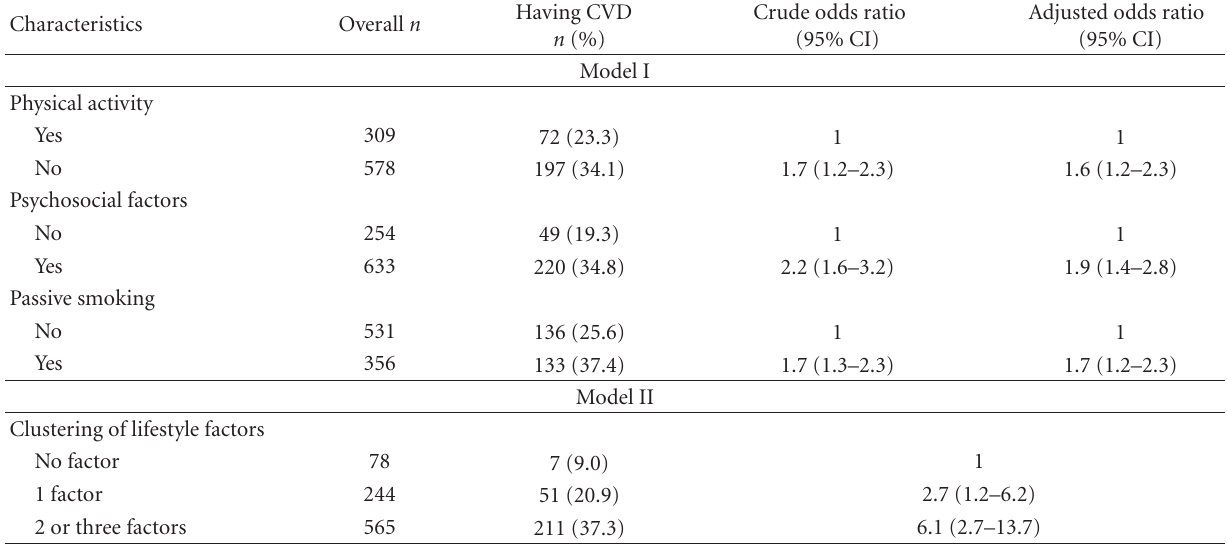
Table 2: Proportion distribution and clustering pattern of lifestyle risk factors and their associations with CVD among study participants.